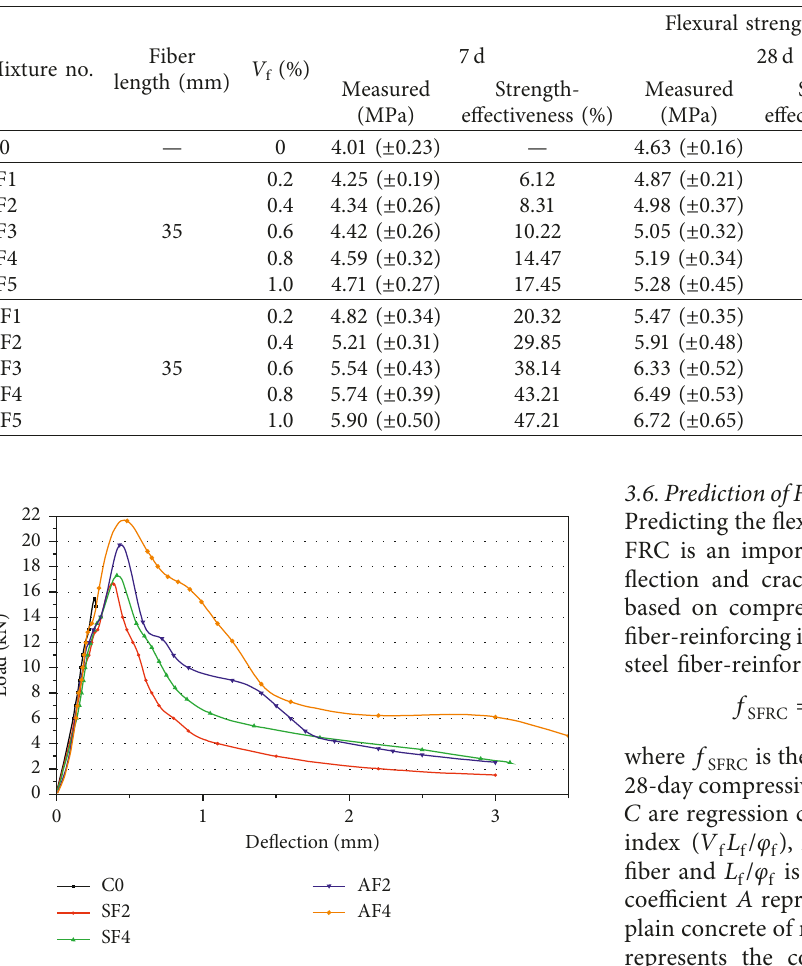
Figure 4: The load-deflection curves of